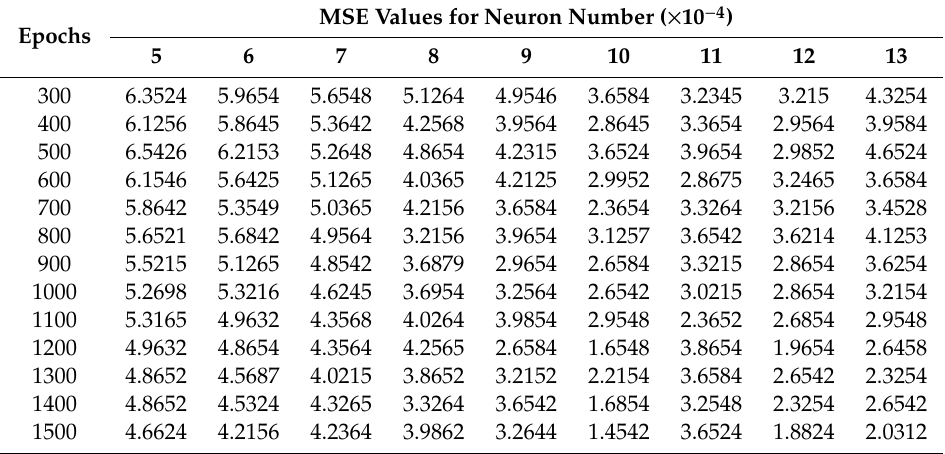
Table 8. Influence of epochs and neuron number of established OANN model on MSE values.